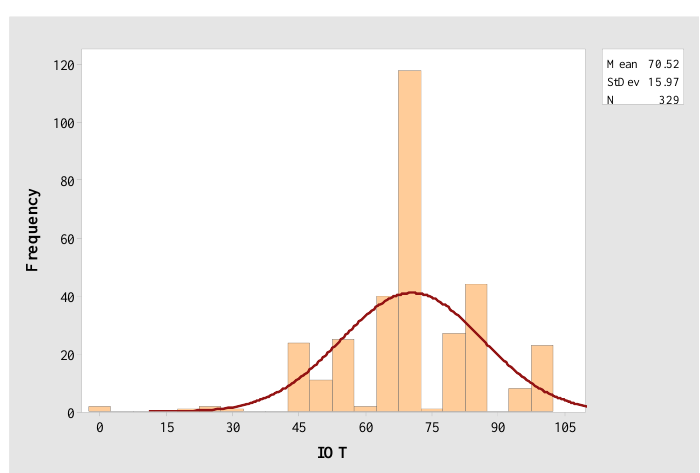
Source : Sample Survey,